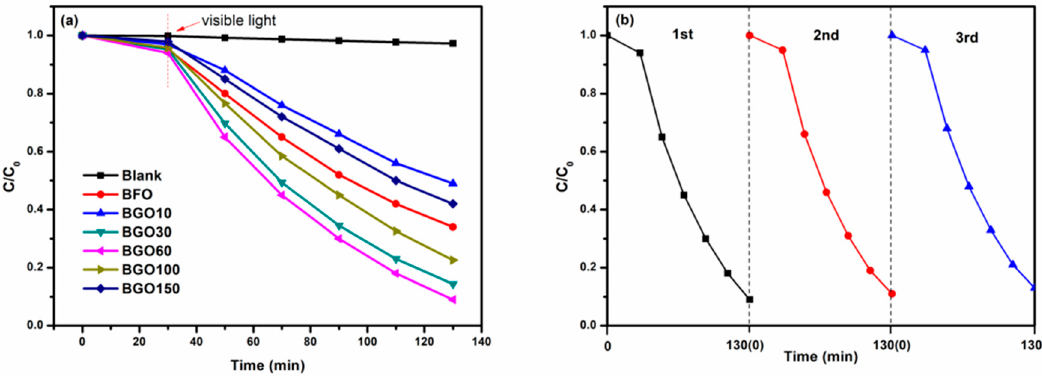
Figure 9. ( a ) Photocatalytic degradation efficiencies of methylene blue (MB) as a function of irradiation time under visible light for BFO and BGO samples, ( b ) Stability test of photocatalytic degradation of MB by BGO60 under visible light irradiation.